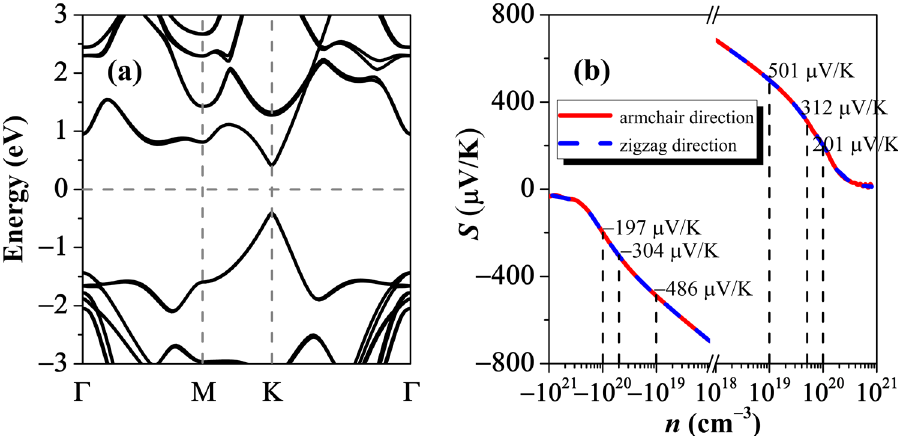
Figure 4. ( a ) The energy band structure, and ( b ) the Seebeck coefficient of the screened BSb/AsP vdWH.